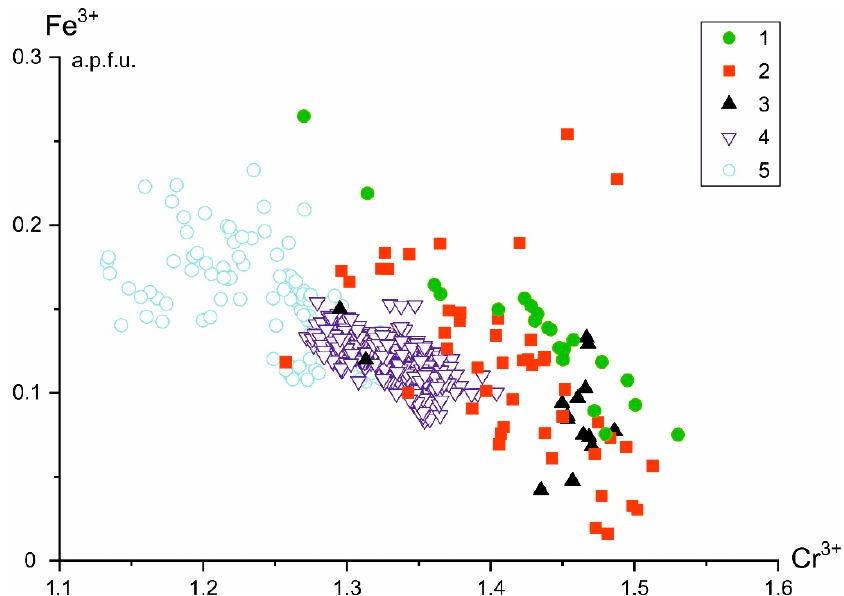
Figure 9. Binary variation diagram in terms of Fe 3+ vs. Cr 3+ (a.p.f.u.) showing the compositions of Cr-spinel from the (1) rich, (2) ordinary and (3) poor ores [1]; (4–5) Cr-spinel from the (4) injection ore veins and (5) host dunites [4].